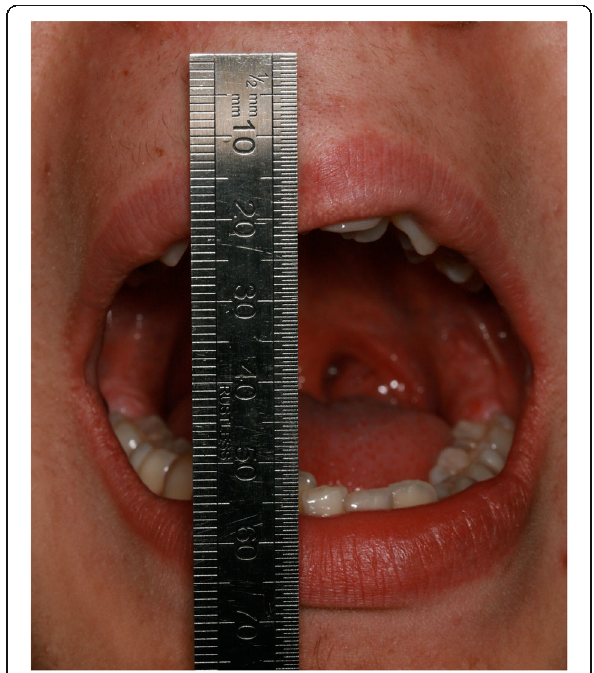
Fig. 13 Normal mouth opening following healing